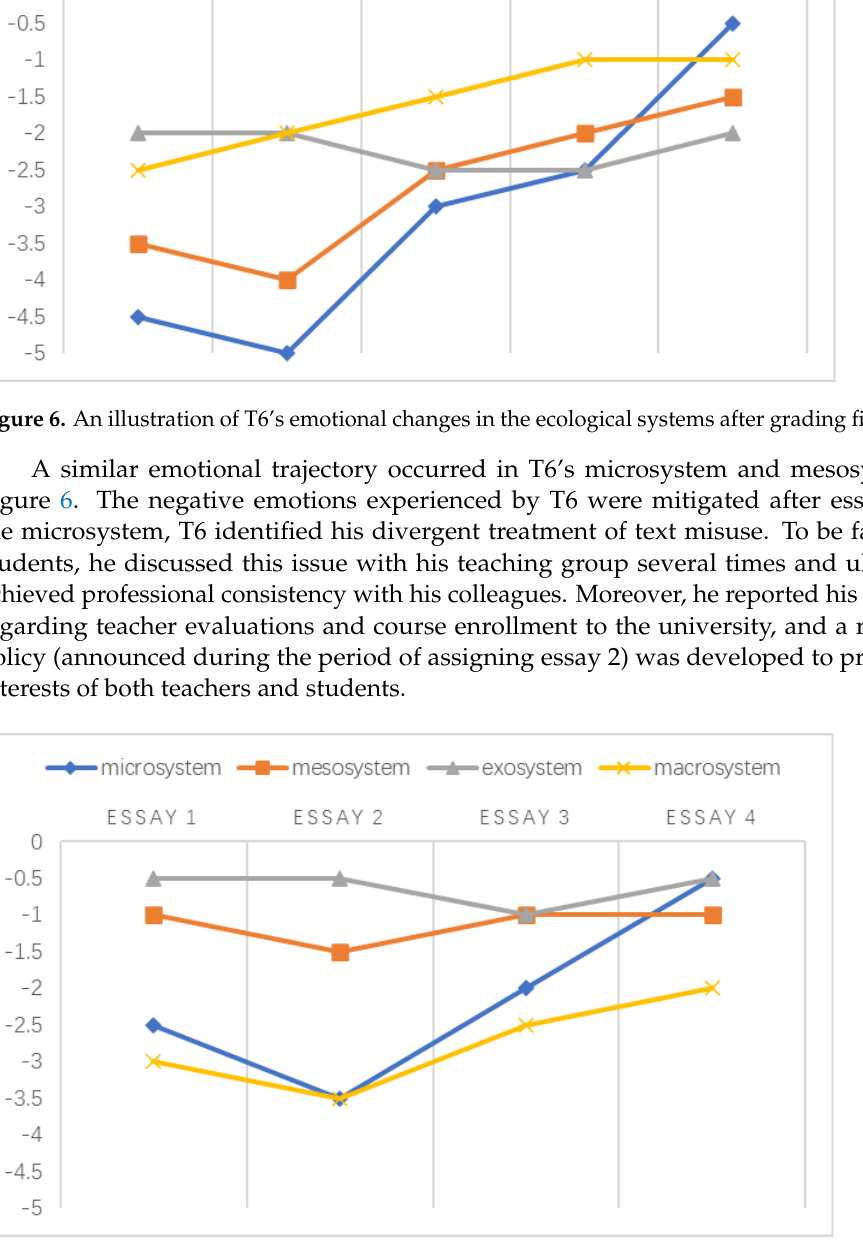
Figure 7. An illustration of T4’s emotional changes in the ecological systems after grading four essays.